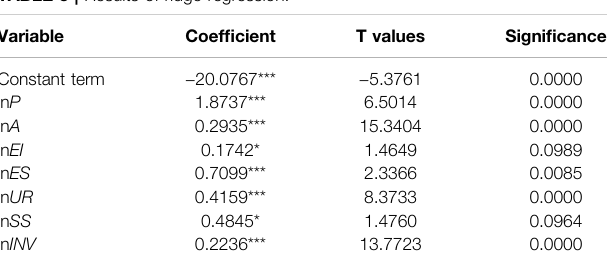
TABLE 3 | Results of ridge